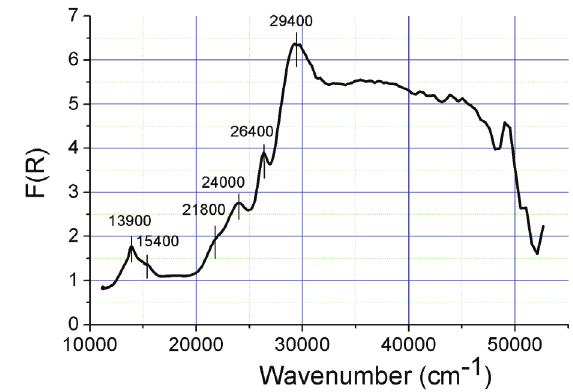
Figure 7b: Typical high resolution TEM image of nanodomains in 5Ni/ Ce Zr O sample. 0.7 0.3 2